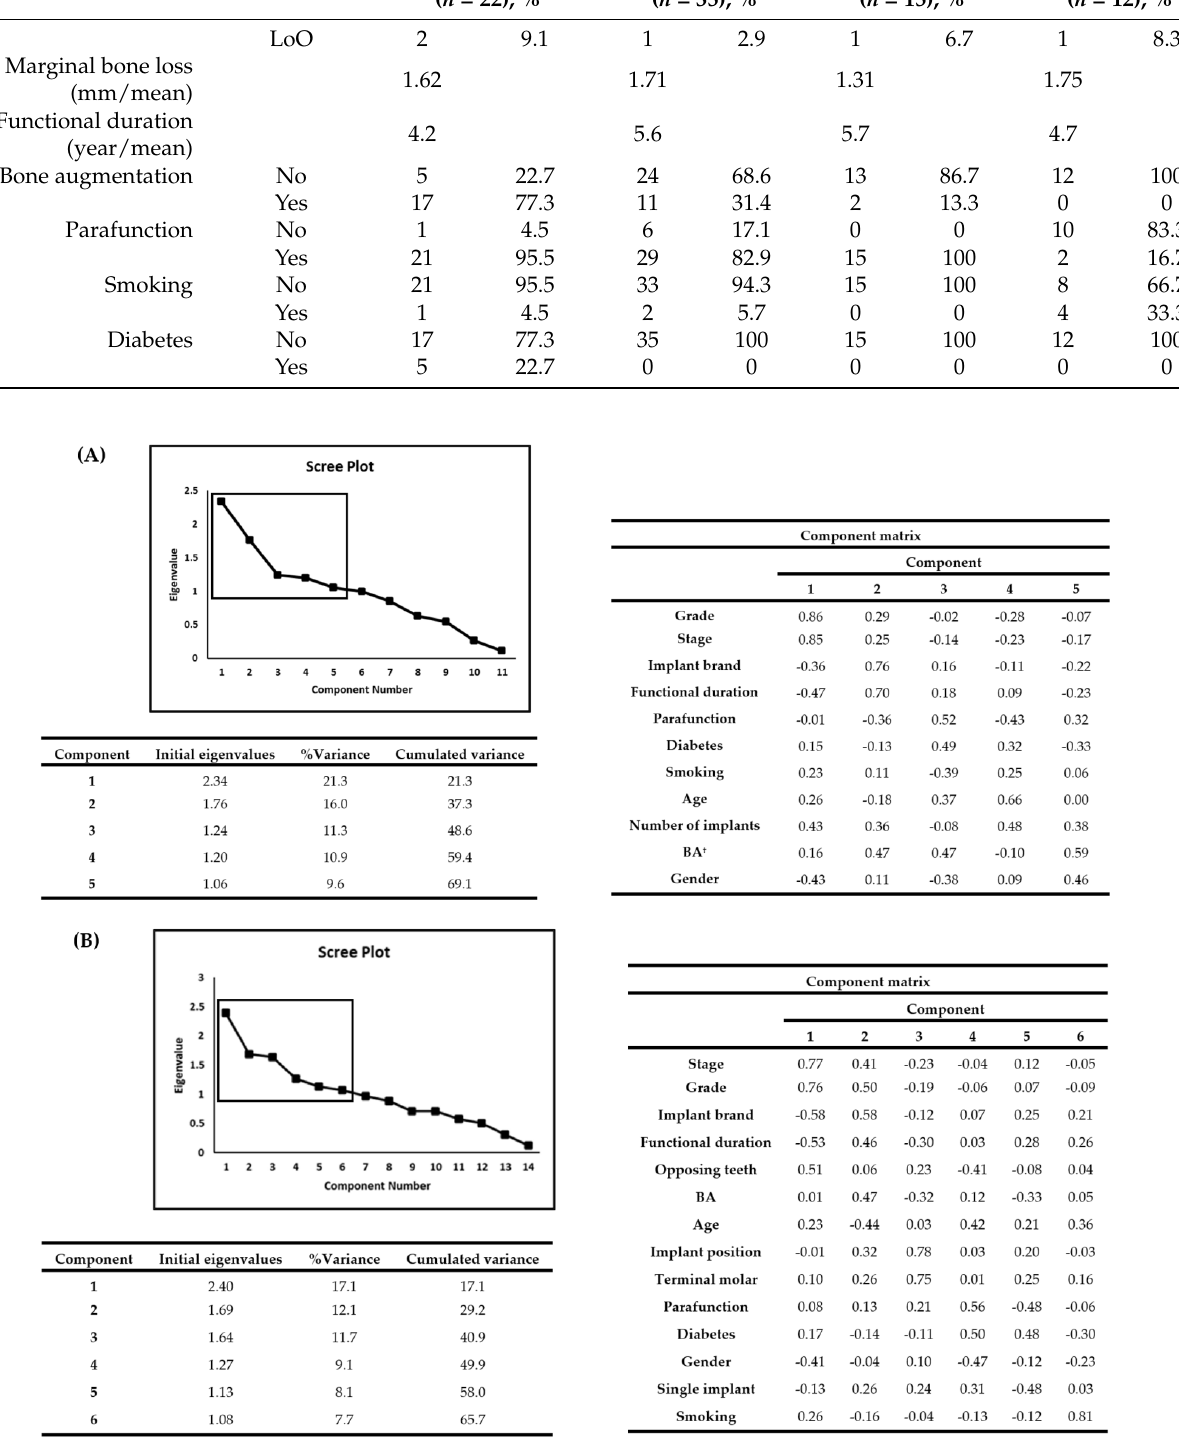
Figure 1. ( A ). Parameters on the steep slope of the scree plot are typically selected as principal. Principal components analysis at patient level. As a result of principal components analysis, the 5 components that showed eigenvalues >1 were selected from the 11 evaluated. †: bone augmentation ( B ). Principal components analysis at implant level . Of the 14 evaluated, 6 components that showed eigenvalues >1 were selected.